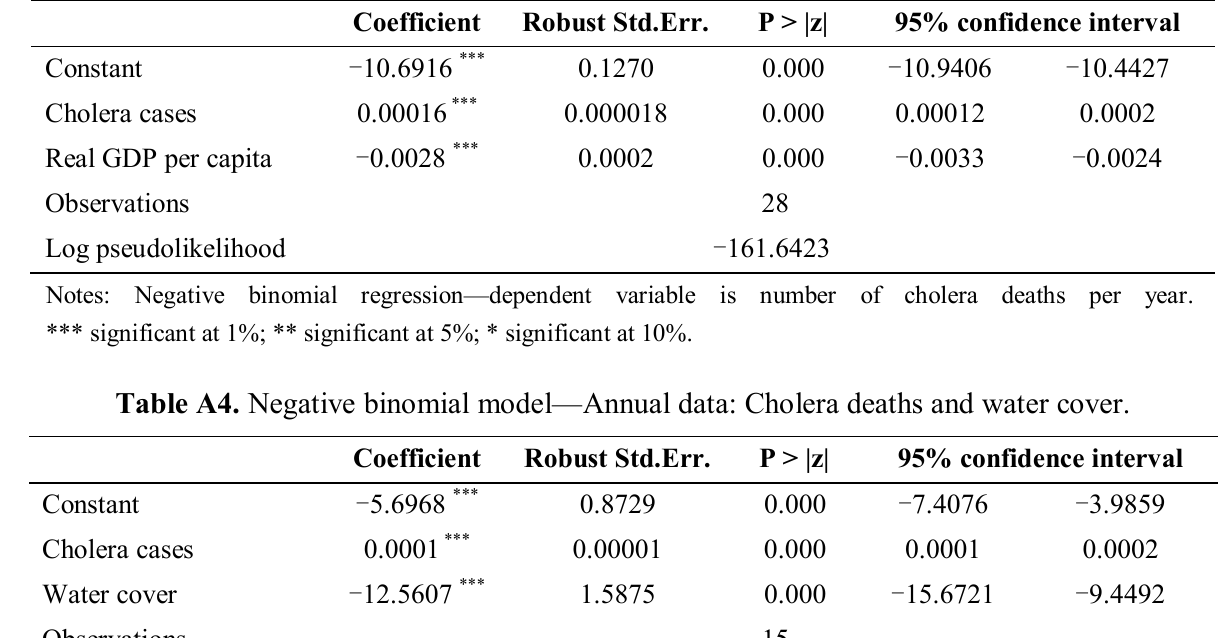
Table A3. Negative binomial model—Annual data: Cholera deaths and income.